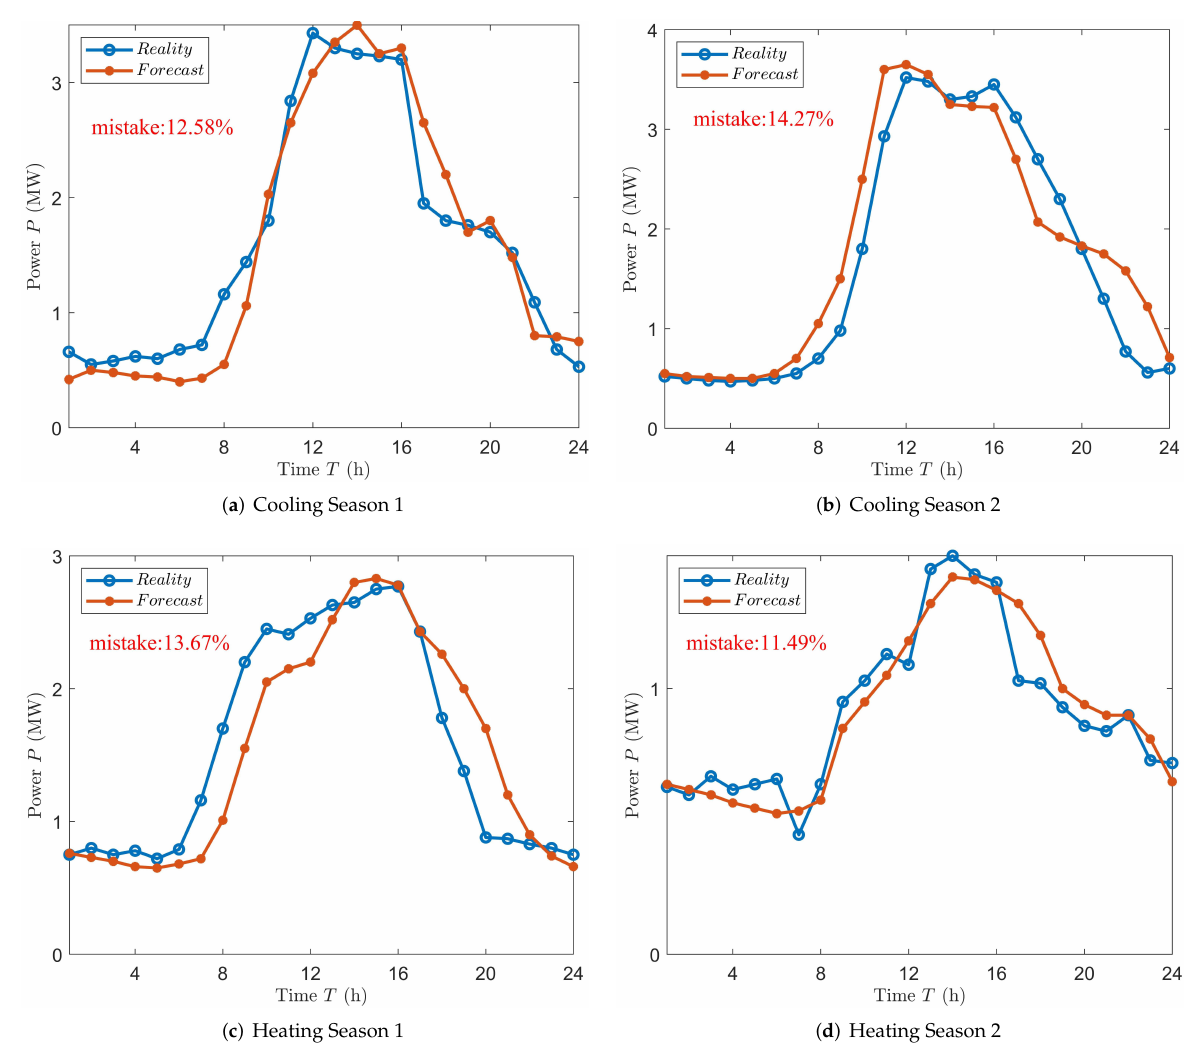
Figure 3. Model testing for training.